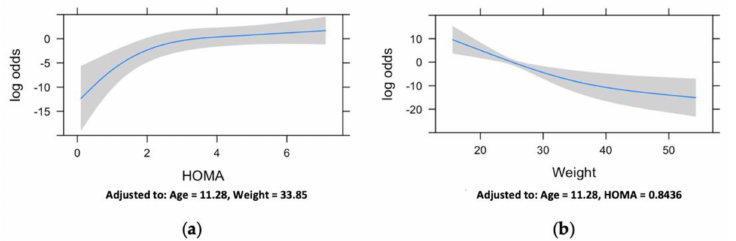
Figure 4. Restricted cubic spline curve showing the model-predicted log odds of being a child with disabilities against homeostasis model assessment for insulin resistance (HOMA-IR) ( a ) and weight ( b ) values. Shadowed areas represent 95% confidence intervals. The curve is derived from a multiple logistic model adjusted for all the covariates. On the Y axis, the conditional effect in terms of the log odds of being a child with disabilities is displayed, whereas, on the X axis, the values of the specific variables are shown. As can be seen in panel ( a ), the HOMA-IR has a major effect in discriminating between the group of children with disabilities and healthy control children at values below 2. In fact, at values greater than 2, the curve almost reaches a plateau. In panel ( b ), the non-linear conditional effect of the weight variable can be observed with a decrease in log odds of being a child with disabilities as weight increases, with a reduction at higher